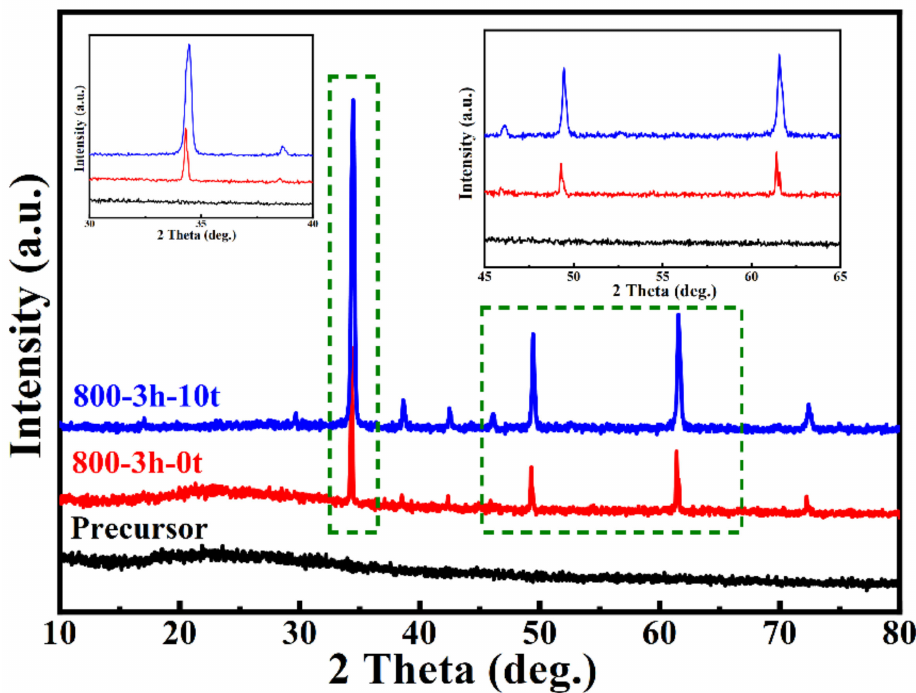
Figure 4. XRD patterns of the black precursor powder, CCTO-800-3 h-0 t, and CCTO-800-3 h-10 t; and the enlarged spectra of selected rectangle areas (insert